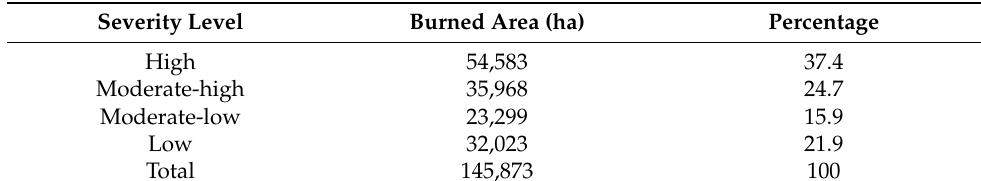
Table 3. Proportion of burned areas by severity class.